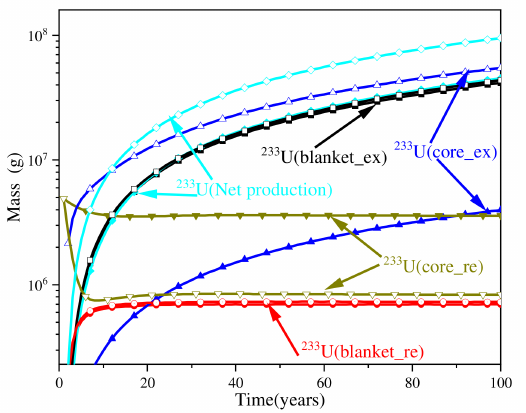
Figure 9. Separate contributions to 233 U production for scenario 3 (solid dot lines) and scenario 4 (empty dot